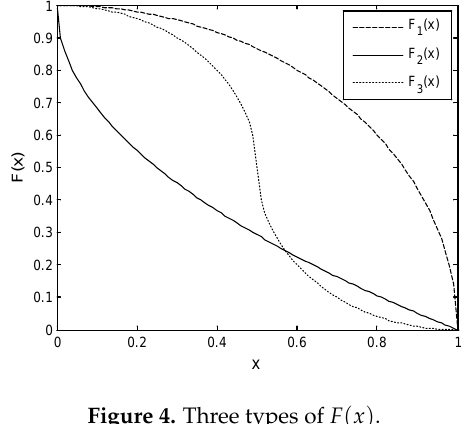
Figure 4. Three types of F ( x ) .